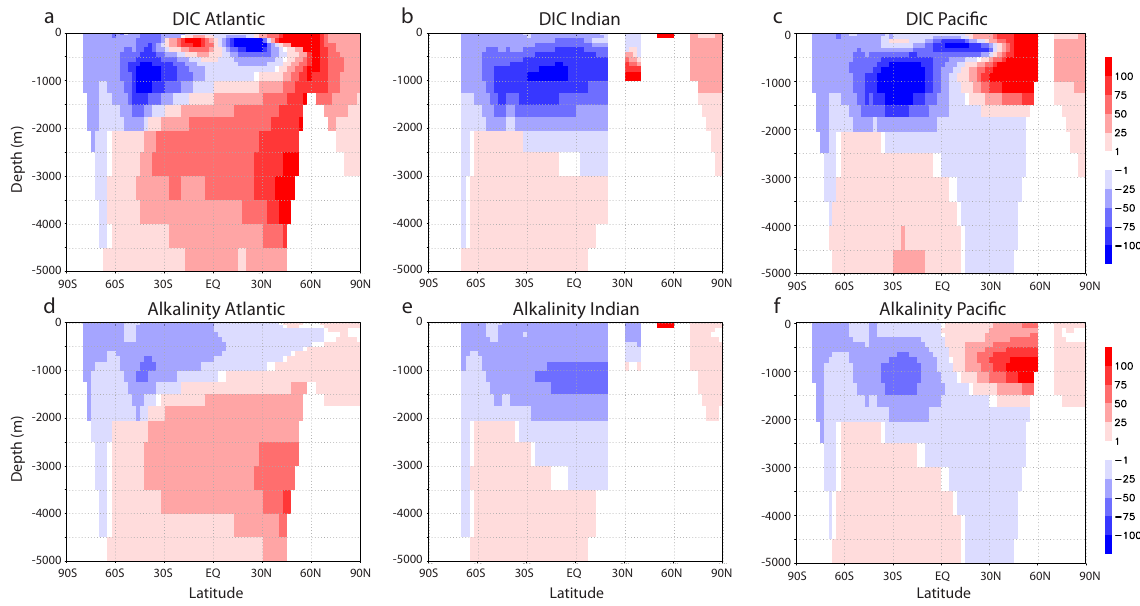
Fig. 6. Zonally averaged dissolved inorganic carbon and alkalinity (µmolkg − 1 ) anomalies for the simulation during the Preindustrial with a fresh water flux added into the North Atlantic of 0.5Sv during 400 yr: (a, b, c) dissolved inorganic carbon and (d, e, f) alkalinity anomalies. The anomalies refer to the difference between the collapse state of the AMOC compared to the control state (years1390–1400 minus years990–1000). The three basins are: (a, d) Atlantic, (b, e) Indian and (c, f) Pacific.